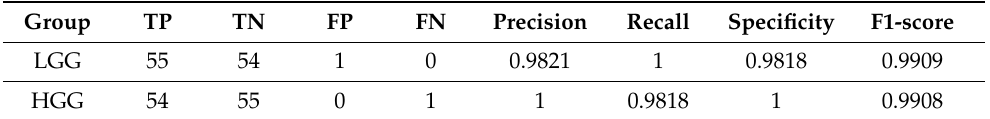
Table 4. Evaluation metrics’ precision, recall, specificity, and sensitivity for the DNN model where the connectivity matrix was used as a matrix is shown (values are given up to four decimal places to track even slight differences in the model’s performance).